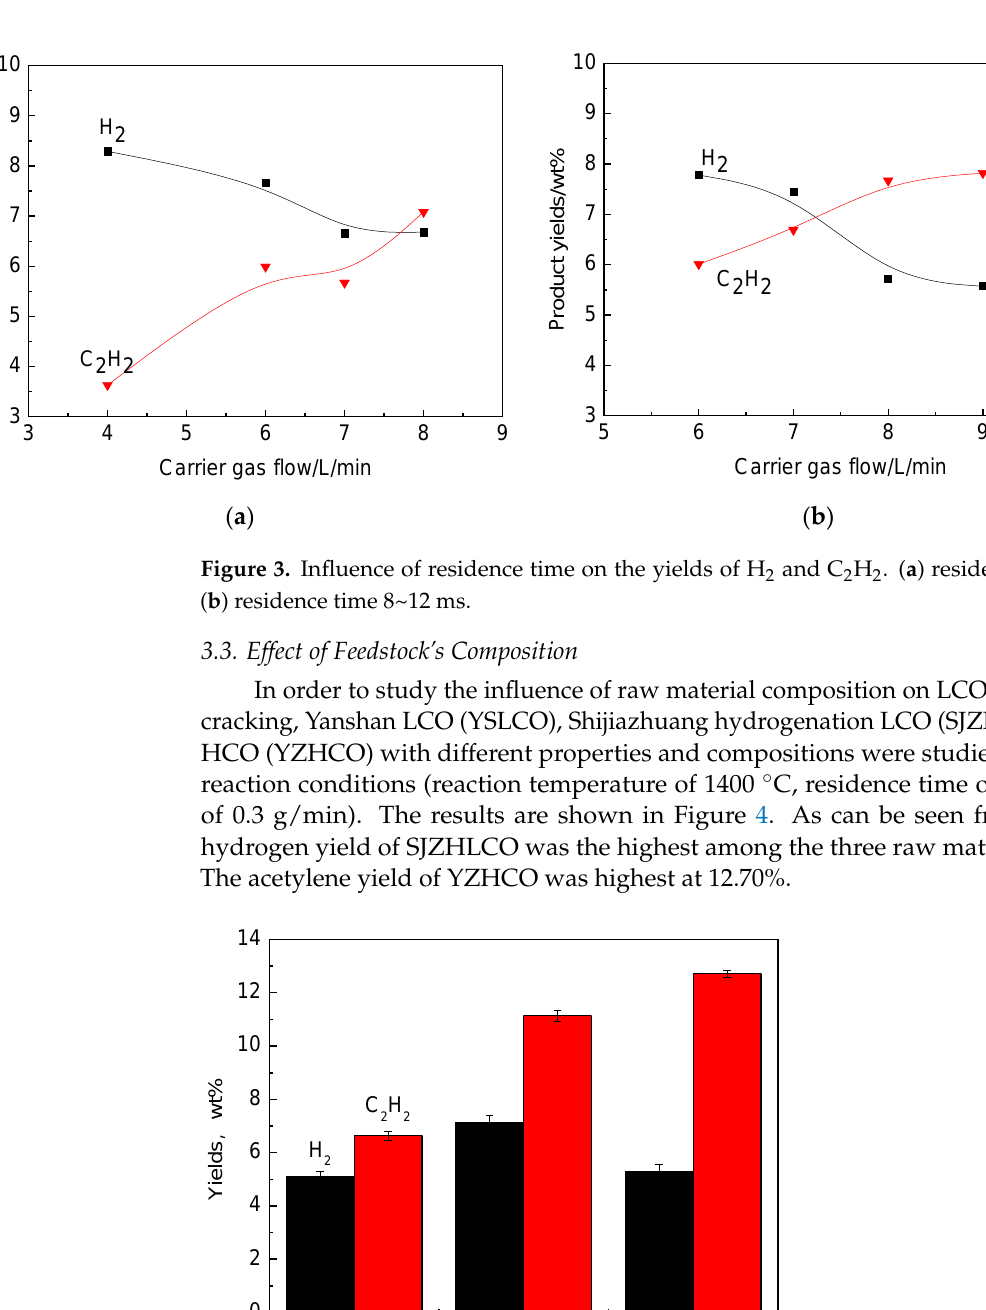
Figure 3. Influence of residence time on the yields of H 2 and C 2 H 2 . ( a ) residence time 24~48 ms. ( b ) residence time 8~12 ms.